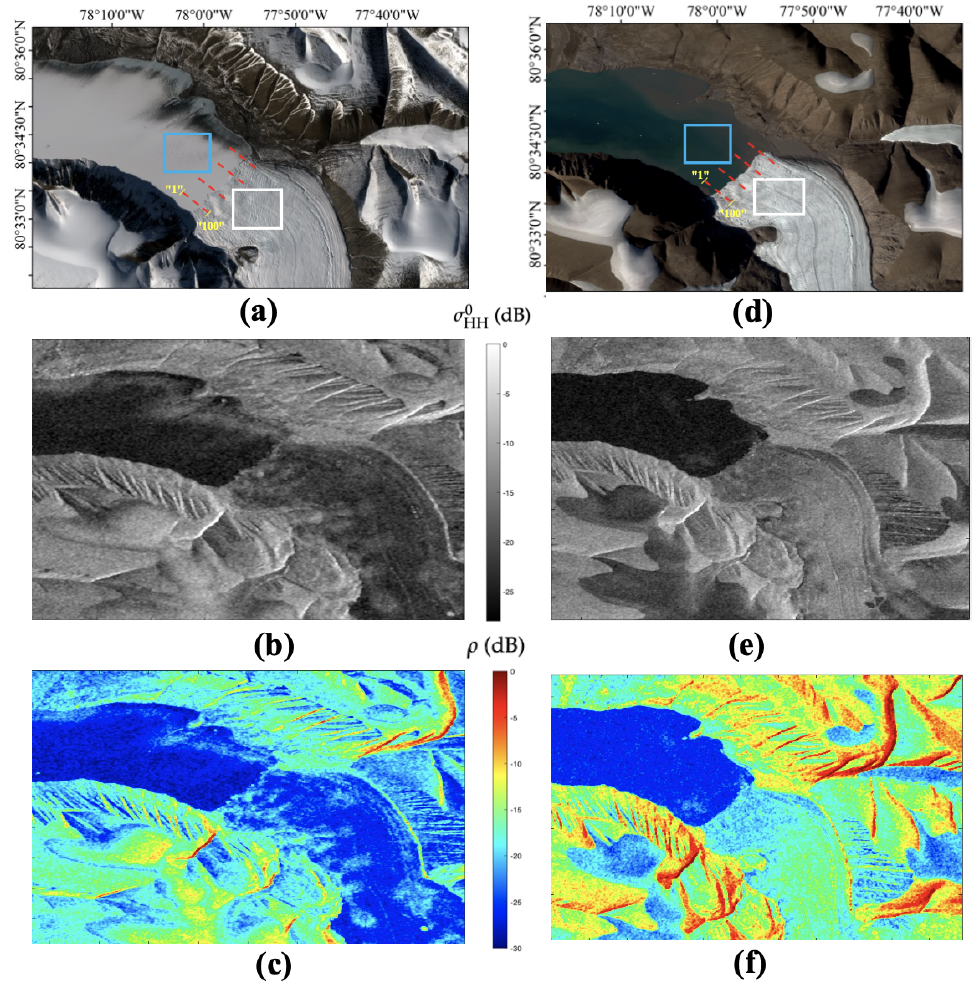
images at the HH